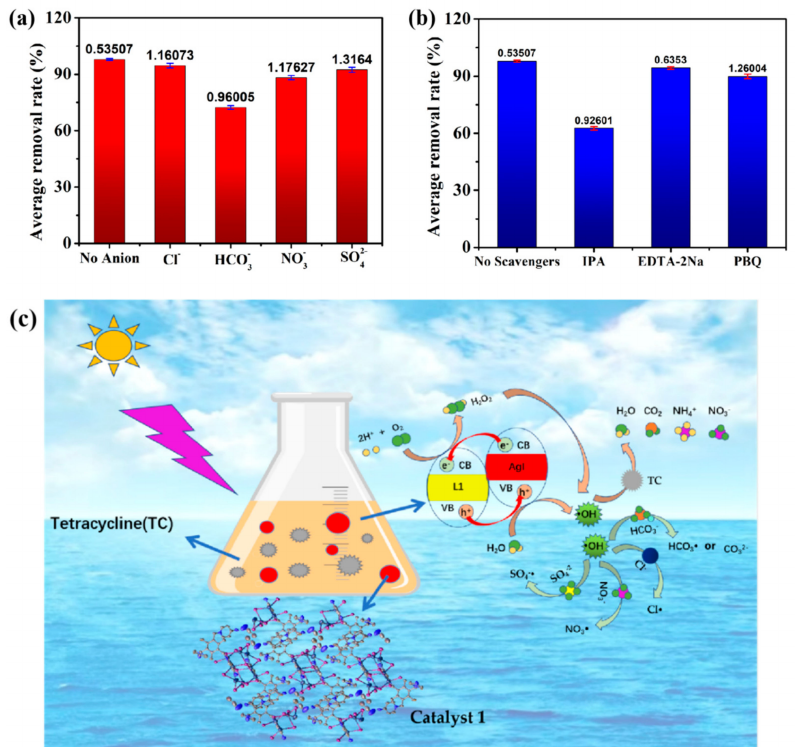
Figure 8. ( a ) Effect of different anions on TC degradation by catalyst 1 . ( b ) Effect of different free radical scavengers on TC degradation by catalyst 1 . ( c ) Photocatalytic degradation mechanism of catalyst 1 under the influence of